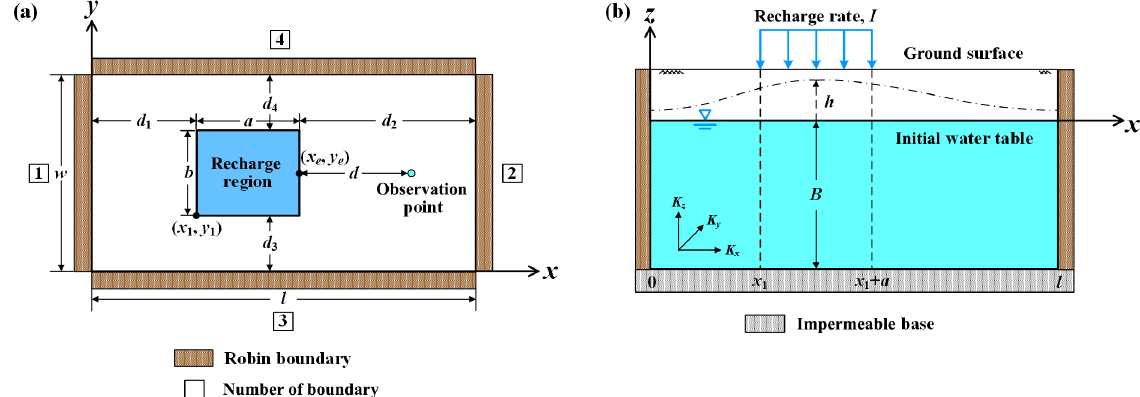
Figure 1. Schematic diagram of a rectangular-shaped unconfined aquifer with localized recharge (a) top view (b) cross section